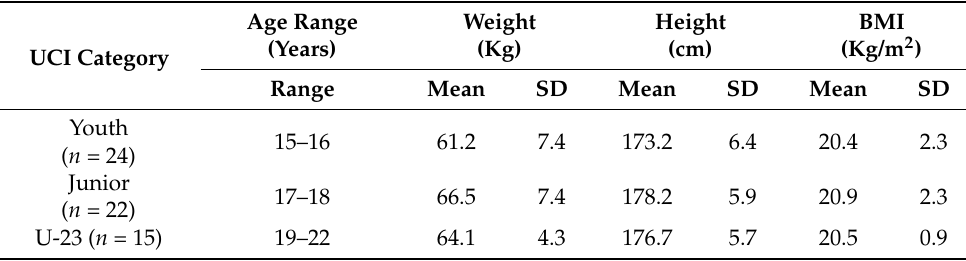
Table 1. General characteristics of the